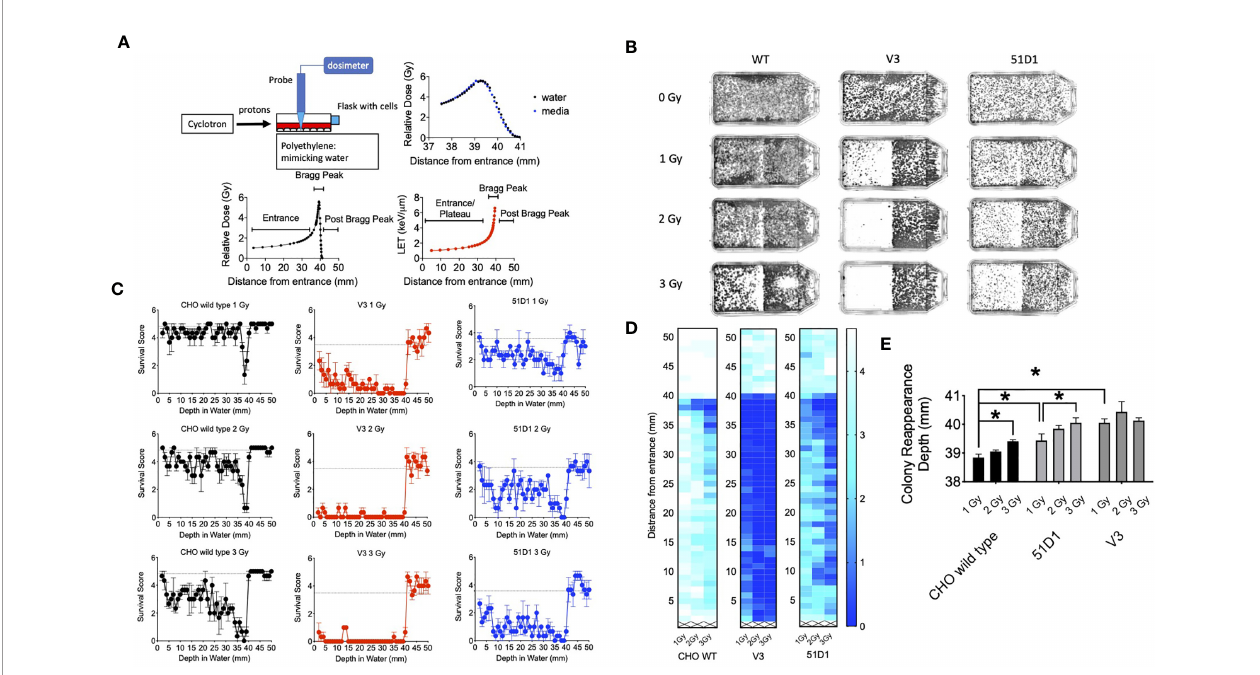
FIGURE 1 | Colony formation after horizontal proton irradiation. (A) Proton irradiation set-up and dose distribution measurement and calculated LET values of protons from the entrance, Bragg peak, and post-Bragg peak. The black lines indicate relative doses in water; the blue points indicate relative doses in cell culture media, and the red line indicates the calculated LET values. (B) Representative images of colony distribution after 0 – 3 Gy of initial proton irradiation to CHO wild type, V3, and 51D1 cells. The proton beam traveled from left to right. (C) Cell survival score after 0 – 3 Gy of initial proton irradiation to CHO wild type, V3, and 51D1 cells. Dashed lines represent the unirradiated control. (D) Heat map of cytotoxicity after proton radiation. Maximum cytotoxicity was observed at 38 mm with 35 – 41 mm from the entrance. The fi rst 1 mm represents the fl ask wall. The right bar, scaled 0 – 4, indicates that a cell survival of 0 represents cell death, while 4 indicates the highest cell survival. (E) Colony reappearance range in different radiosensitive cells. Error bars indicate the standard error of the means. * means statistically signi fi cant differences (P <